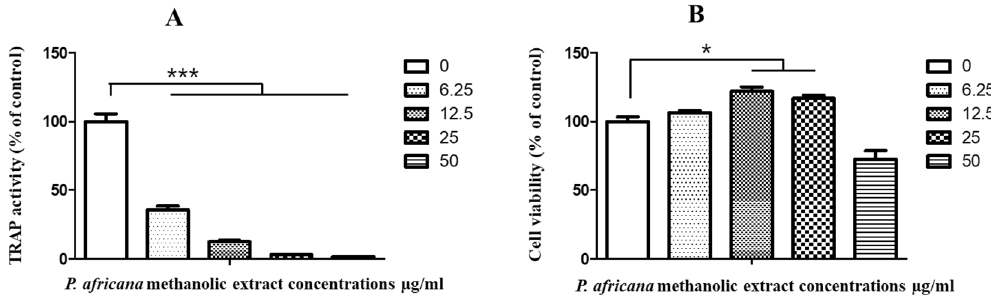
Figure 2. Effect of P. africana on TRAP activity in BMM. The BMM were cultured with P. africana bark extracts in the presence of RANKL for 6 days and TRAP activity of osteoclasts measured by colorimetric assay using p-nitrophenyl phosphate as a substrate. Cell viability was determined using Cell Counting Kit-8 following manufacturer’s instruction. * p < 0.05 and *** p <